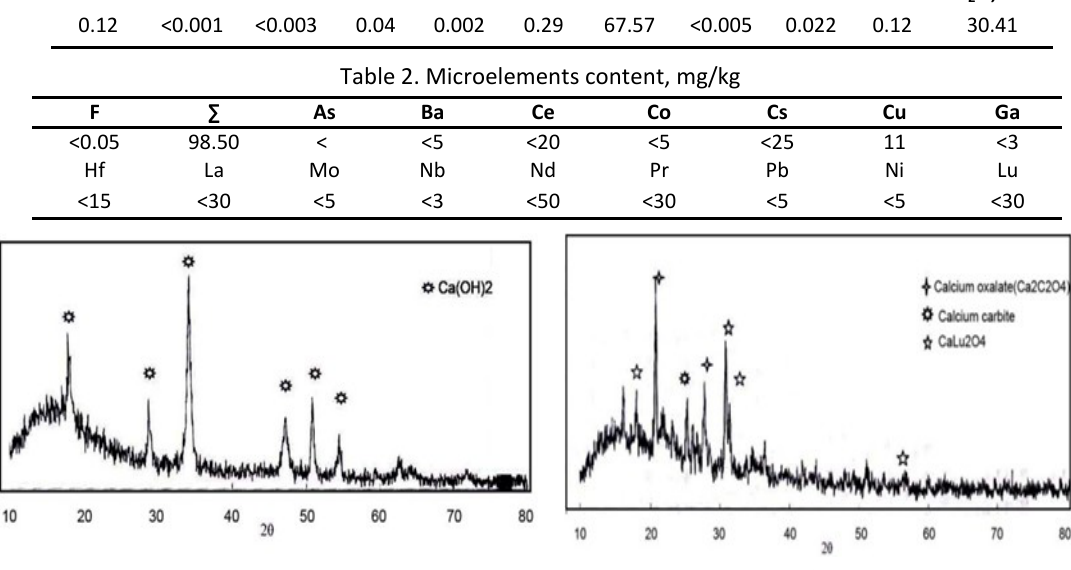
Fig. 2. Calcium hydroxide content in the nutrited Fig. 3. Characteristics of metal-organic bond in the structure of the tamed spar